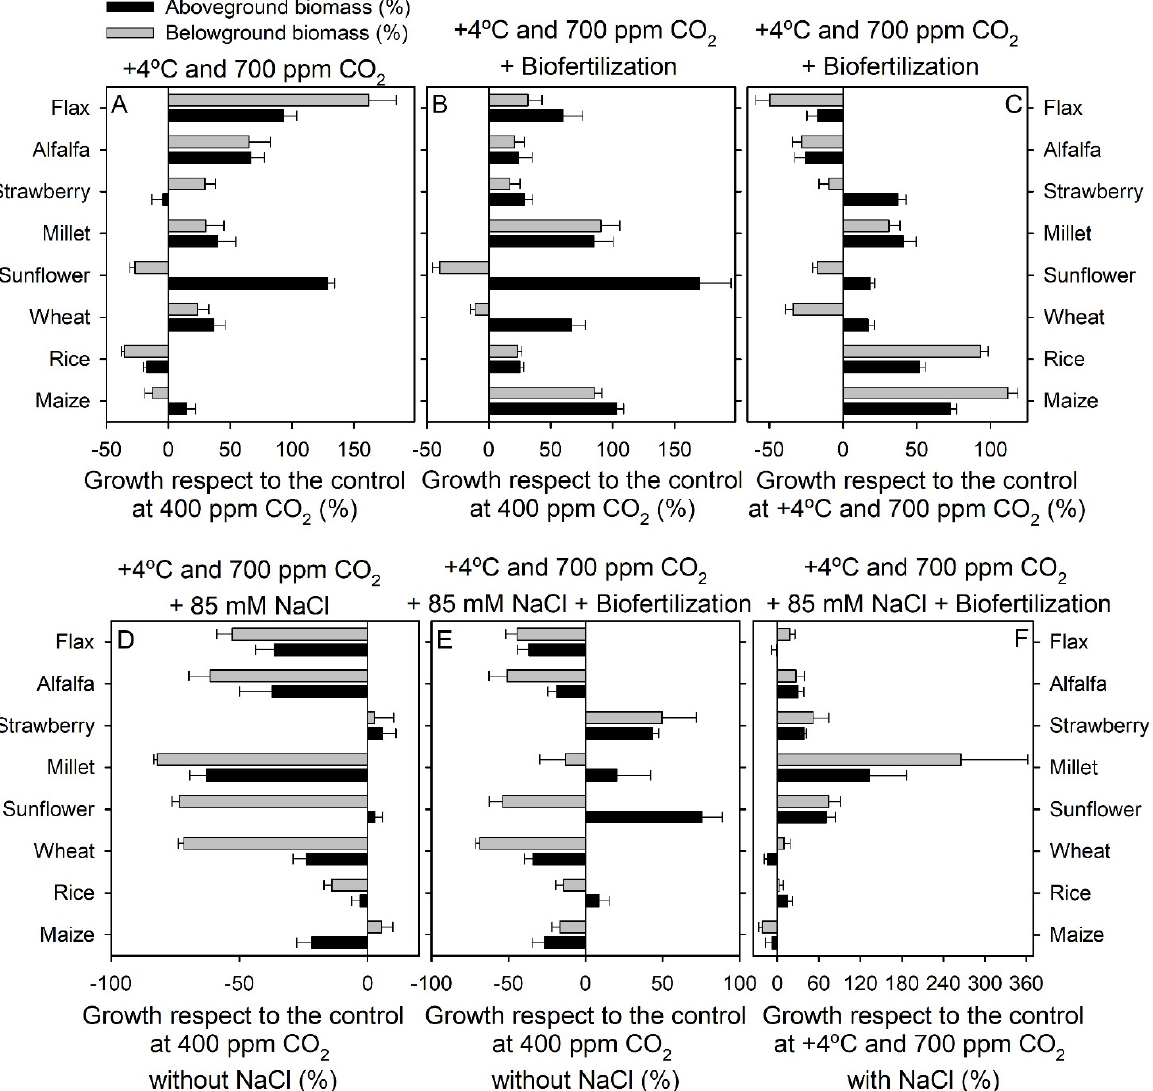
Figure 3. Effect of the most effective biofertilizer for each crop on its growth in the future climate scenario. ( A ) Growth of above ‐ and below ‐ ground biomass production of crops grown at 700 ppm CO 2 and 29/18 °C expressed as a percentage of that at 400 ppm CO 2 and 25/14 °C. ( B ) Growth of above ‐ and below ‐ ground biomass of crops grown with biofertilization at 700 ppm CO 2 and 29/18 °C, expressed as a percentage of biomass produced at 400 ppm CO 2 and 25/14 °C without biofertilizer. ( C ) Growth of above ‐ and below ‐ ground biomass of crops grown with biofertilization at 700 ppm CO 2 and 29/18 °C temperature, expressed as a percentage of biomass produced under the same conditions but without biofertilizer. ( D ) Percentage change in above ‐ and below ‐ ground biomass production of non ‐ inoculated and ( E ) inoculated crops, grown with 85 mM NaCl, with respect to non ‐ inoculated controls grown both at 400 ppm CO 2 without and ( F ) with NaCl at 700 ppm CO 2 and 29/18 °C. Each value represents the mean of ten replicates (twenty for rice) ± SE. Note: the label in the upper part of the graph indicates the treatment that is presented and the label in the lower part indicates with respect to which control treatment the percentage change of biomass was calculated.